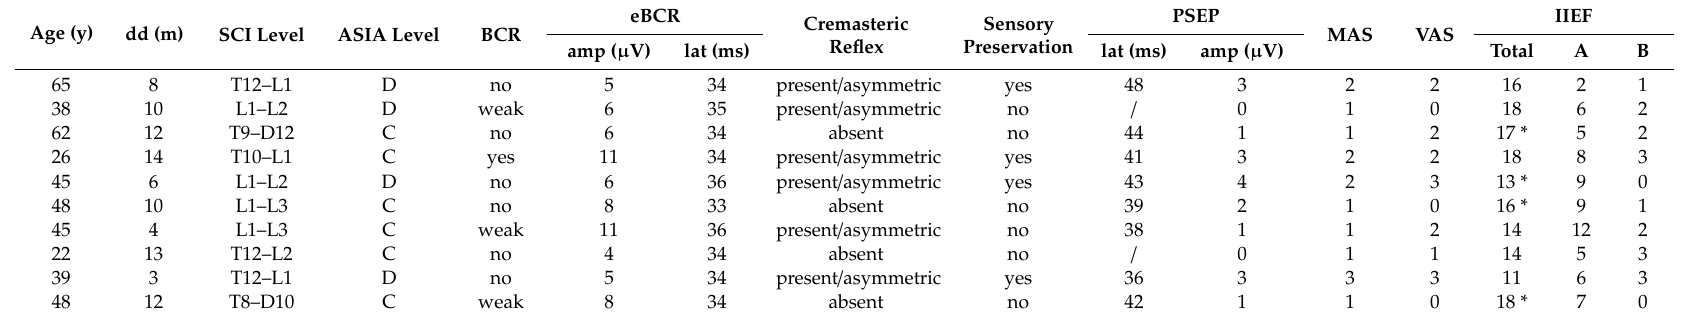
Table 1. Clinical-demographic characteristic of the sample at